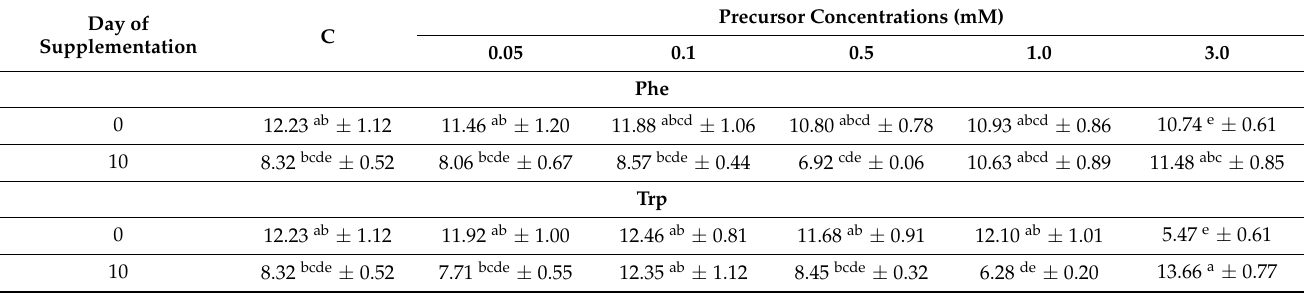
Table 1. Growth index (Gi ± SD) values reached by bioreactor-grown N. officinale microshoot cultures after precursor feeding. Day of